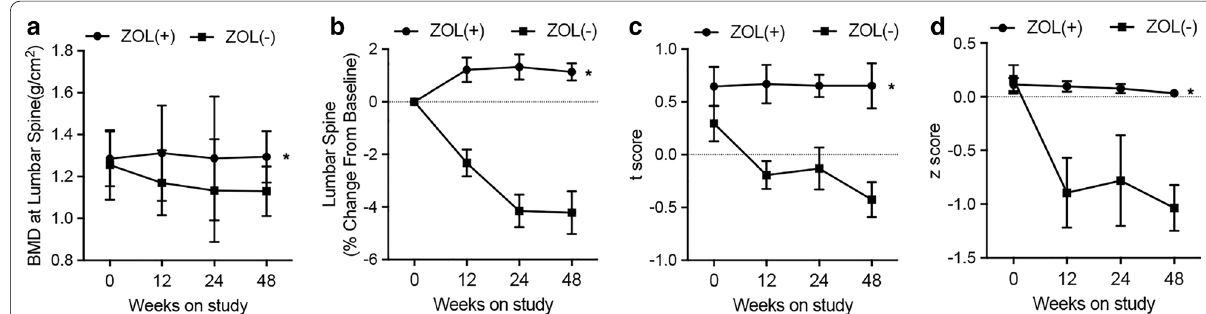
Fig. 2 BMD Loss was repressed by ZOL treatment in HIV patients receiving tenofovir treatment. a Model‑based mean longitudinal changes in BMD at the lumbar spine in 48 weeks in ZOL‑treated HIV patients receiving tenofovir treatment. b Model‑based mean BMD percentage change at the lumbar spine from baseline in 48 weeks in ZOL‑treated HIV patients receiving tenofovir treatment. c Model‑based mean longitudinal changes in lumbar spine t scores in 48 weeks in ZOL‑treated HIV patients receiving tenofovir treatment. d Model‑based mean longitudinal changes in lumbar spine z scores in 48 weeks in ZOL‑treated HIV patients receiving tenofovir treatment